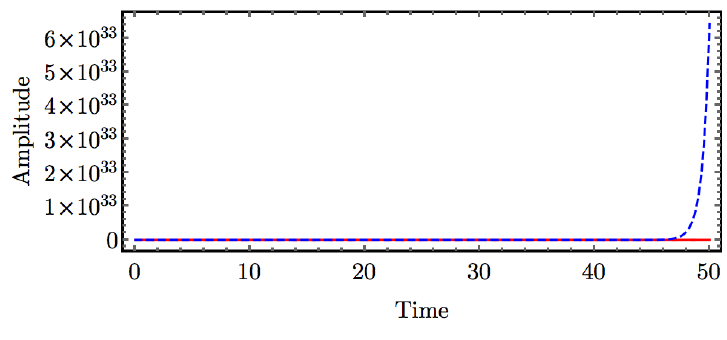
Figure 7. The red curve is the numerical solution and the dashed blue curve is the DTM solution in Equation